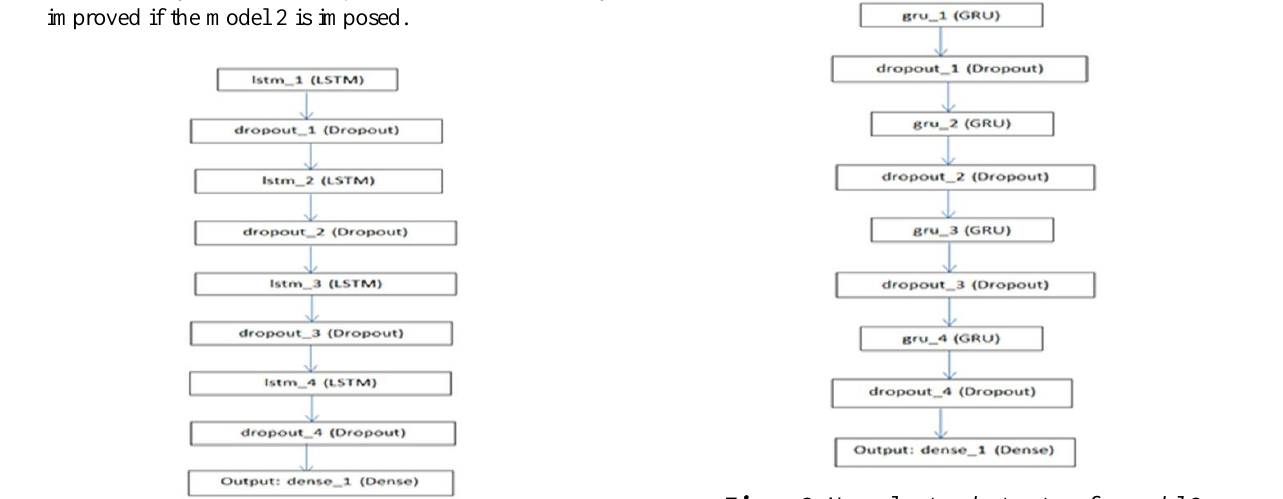
Figure 3: Neural network structure for model 2.